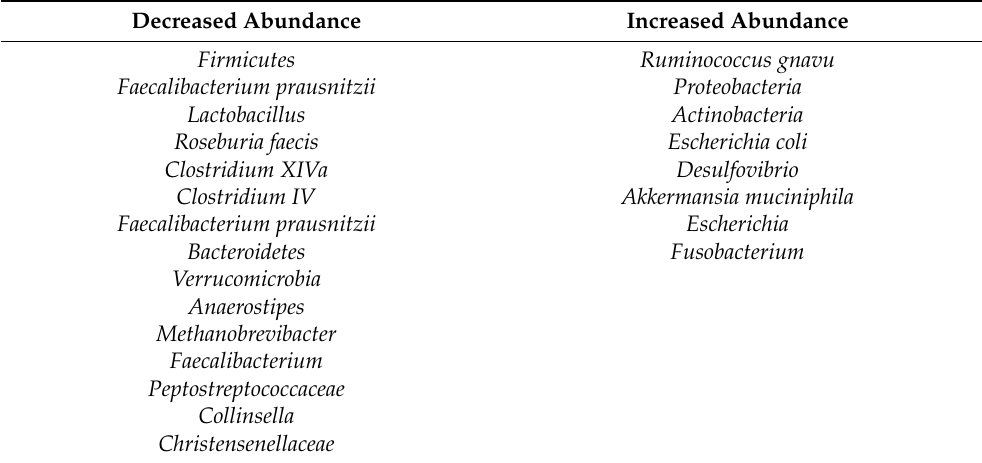
Table 4. The most important changes in gut microbiota in inflammatory bowel disease. Decreased Abundance Increased Abundance